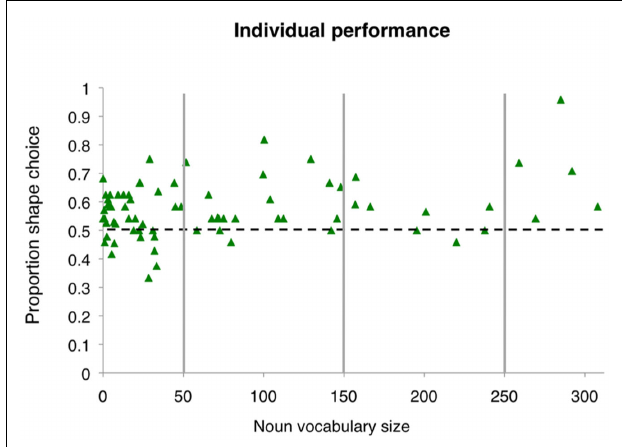
FIGURE 4 | Proportion shape responding and productive noun vocabulary size for each participant. Vocabulary subgroup divisions marked by vertical gray